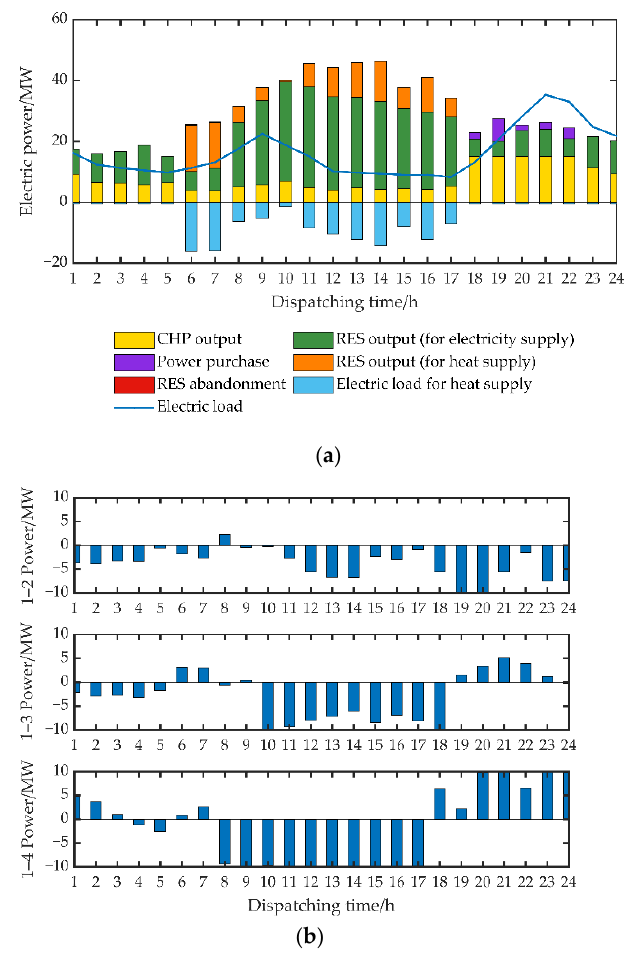
Figure 11. Dispatching strategy of the residential area under joint dispatching: ( a ) Electric power of the residential area; ( b ) Electric power of the tie lines.